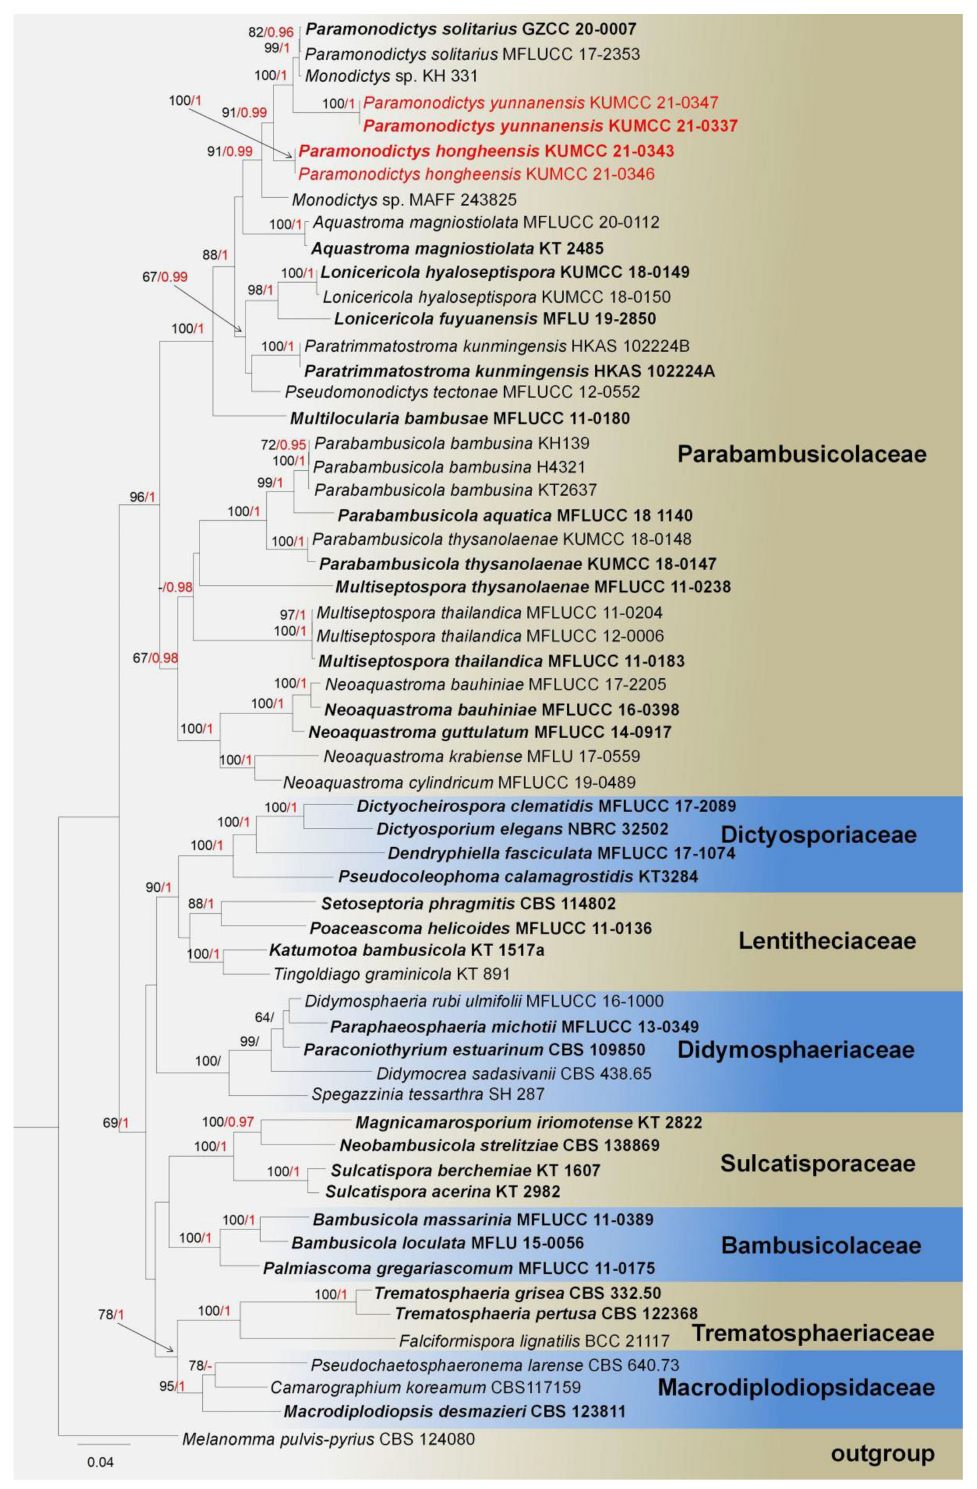
Figure 8. Phylogram generated from maximum likelihood analysis based on a combined SSU, LSU, ITS, and tef1- α sequence datasets. Related sequences were taken from Dong et al. and Hyde et al. [83,84]. The 59 strains are included in the combined gene analyses’ 3540 total char- acters, including gaps (LSU: 1–879 bp, SSU: 880–1907 bp, tef1- α : 1908–2841 bp, ITS: 2842–3540 bp). Tree topology of the ML analysis was similar to the BI. The matrix had distinct alignment patterns, with the final ML optimization likelihood value of − 27,170.920818 (ln). All free model parameters were estimated by RAxML model, with 1459 distinct alignment patterns and 21.90%